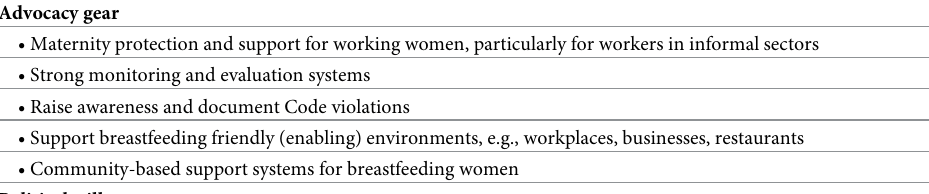
Table 3. Key recommendations to support the Code using the Gear